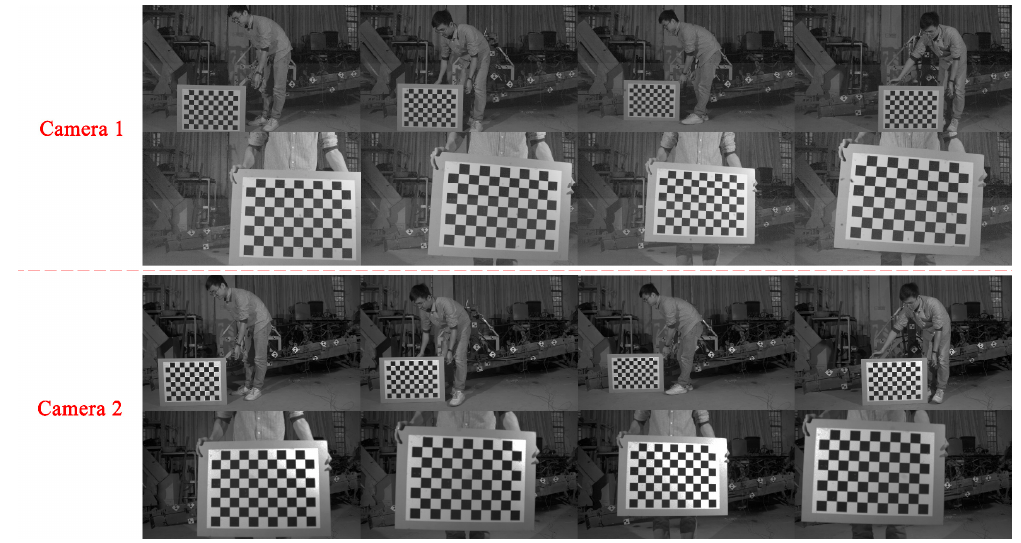
Figure 7. Part of the checkerboard images.